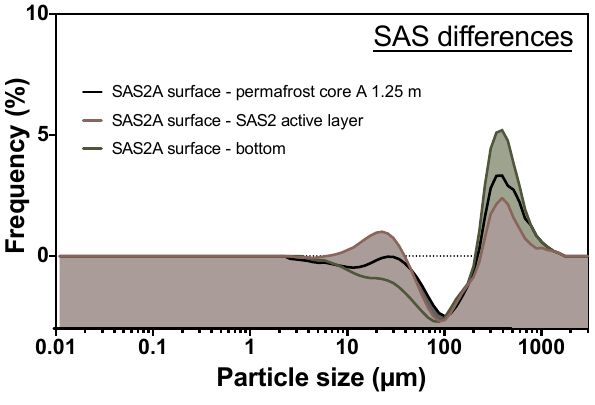
Figure 5. Difference spectra between the frequency distribution of particles in surface lake water (SAS2A) relative to active layer soil, permafrost and bottom lake